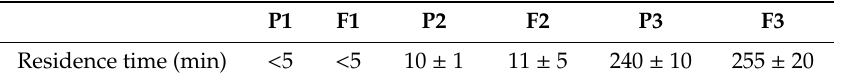
Figure 7. Mucoadhesion ( W ad ) placebo (P1–P3) and chitosan tablets with Chelidonii herba lyophilized extract (F1–F3) with porcine vaginal mucosa compared to cellulose acetate paper control (PC) ( n = 4; mean ± SD). Table 4. Adhesion times of placebo (P1–P3) and chitosan tablets with Chelidonii herba lyophilized extract (F1–F3) to the porcine vaginal mucosa ( n = 3; mean ±